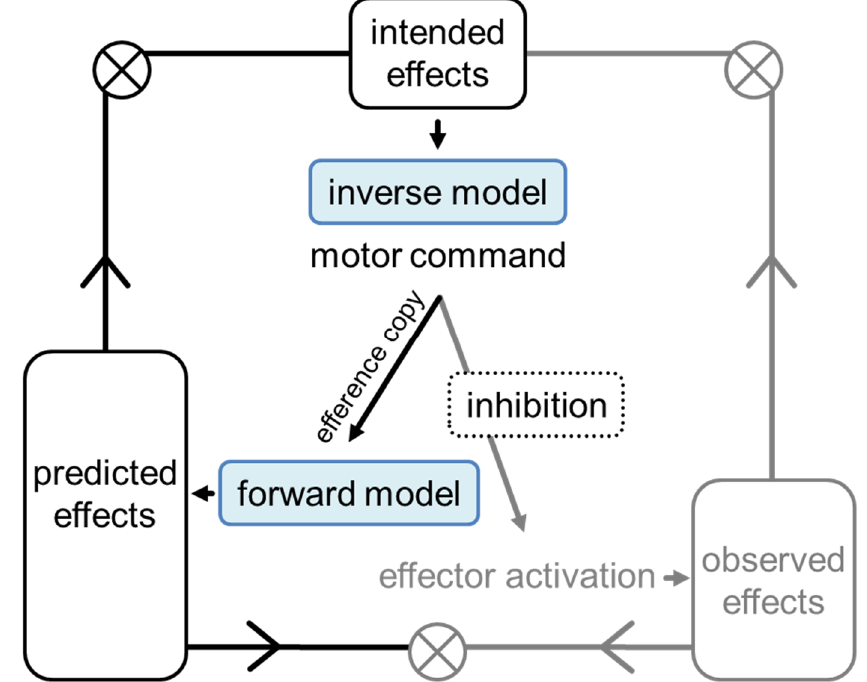
Figure 1. Framework of internal models (adapted from [26]). The mechanisms in black may be used in both motor execution and motor imagery. The mechanisms in gray may not be used (or to a lesser degree) in motor imagery due to inhibition.